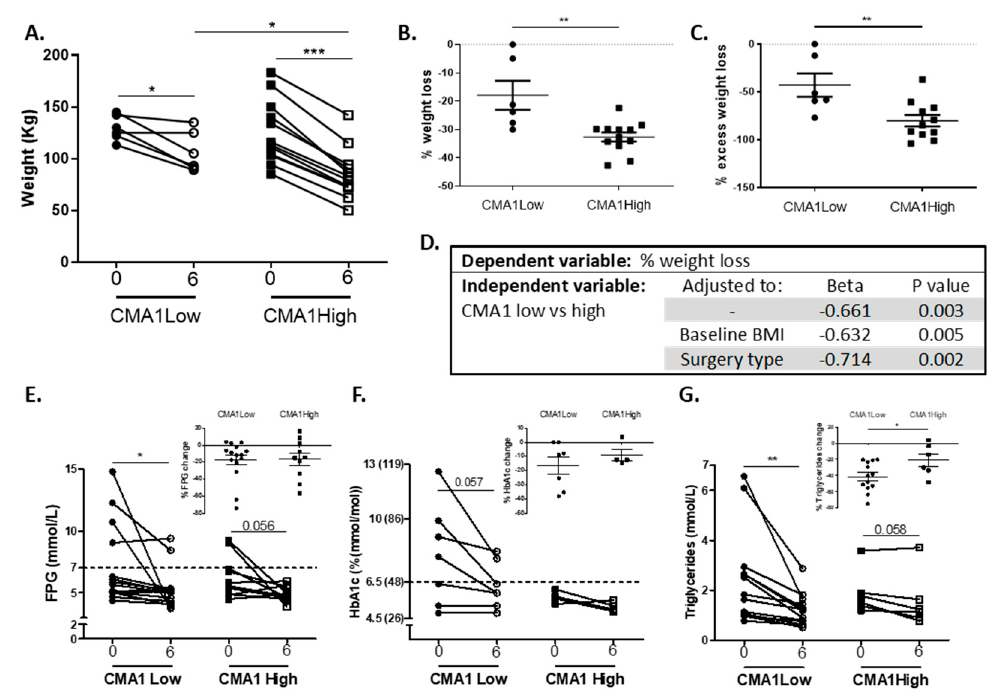
Figure 5. Six months postoperative weight reduction and metabolic changes comparison between people with VAT CMA1 high or CMA1 low. ( A ) Body weight change between operation day (0) and 6 months post-surgery in persons with low expression (i.e., below median) of CMA1 ( n = 6, circles) or high CMA1 mRNA levels (n = 12, squares). Percentage of weight loss ( B ) from preoperative weight and of excess weight loss six months following bariatric surgery ( C ). A paired t-test was used to compare between pre-operation (0) and 6 months post-surgery (6). A Mann–Whitney non-parametric test was performed in order to compare means between CMA1 low and CMA1 high. * p < 0.05, ** p < 0.01. ( D ) Multi-variant model for association between VAT CMA1 groups and 6 months weight changes as dependent variable, adjusted to baseline BMI and surgery type. Change in FPG ( E ), HbA1c ( F ), and triglycerides ( G ) between operation day (0) and 6 months post-surgery in persons with low expression CMA1 or high CMA1 mRNA levels. The percentage of change in FPG, HbA1c, and triglycerides (insets). Values are expressed as mean ± standard error of the mean (SEM). To strengthen the limited observation achievable with our main cohort, we utilized validation cohort 2 of the Leipzig bio-bank, in which 1 year post-laparoscopic sleeve gastrectomy data was available (see details of this 2-step bariatric surgery cohort in the Methods section). As expected, there were significant declines in weight and anthropometric measures, in glycemic and insulin resistance indices, and in lipids (increase in HDL) (Table 3).